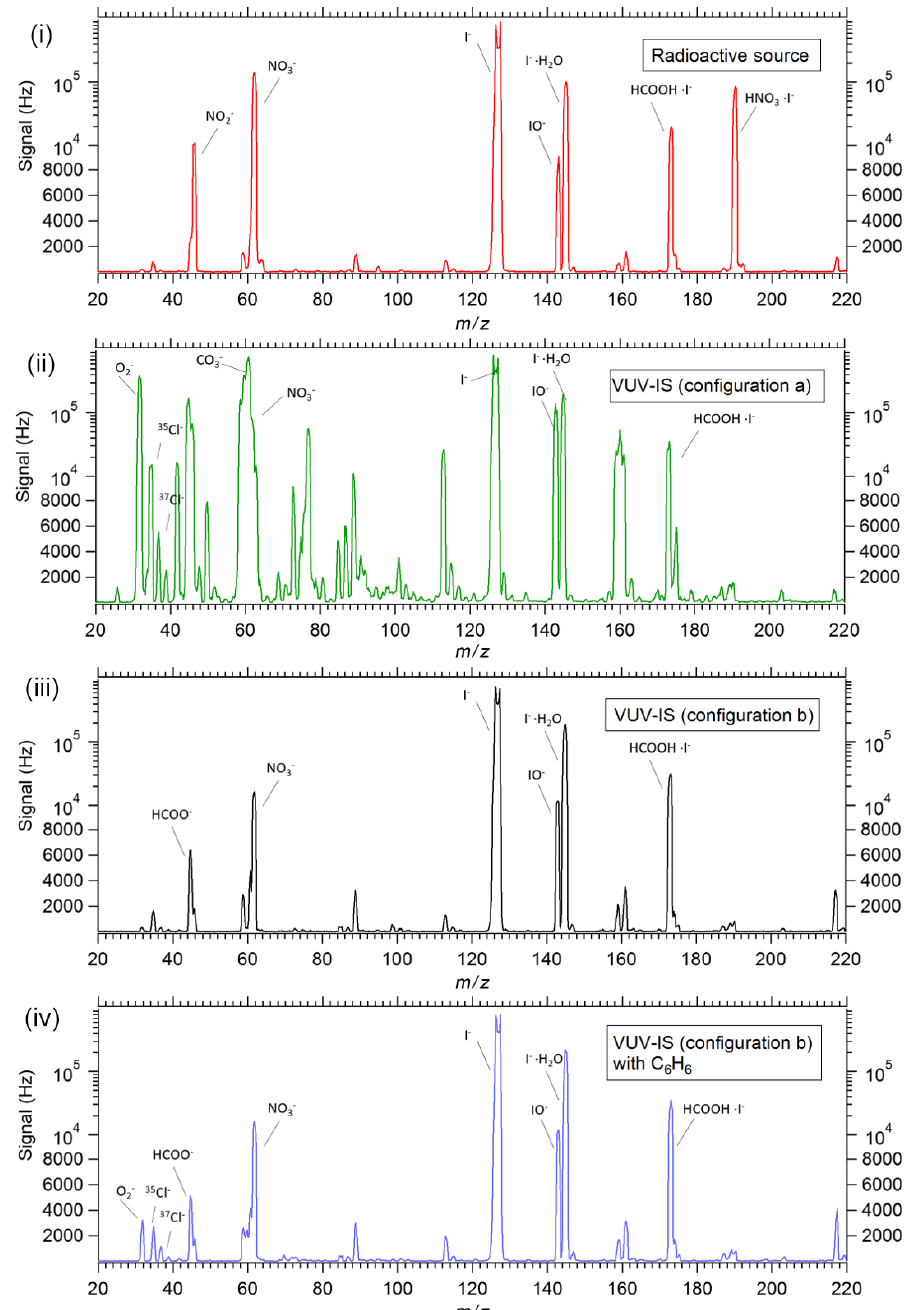
Figure 5. Mass spectra of ambient air from a Q-CIMS with (i) a standard radioactive ion source, (ii) VUV-IS in configuration (a), (iii) VUV- IS in configuration (b), and (iv) VUV-IS in configuration (b) with ∼ 100ppmv of C 6 H 6 and ∼ 10ppmv of CH 3 I. Note that the I − signal is saturated in all mass